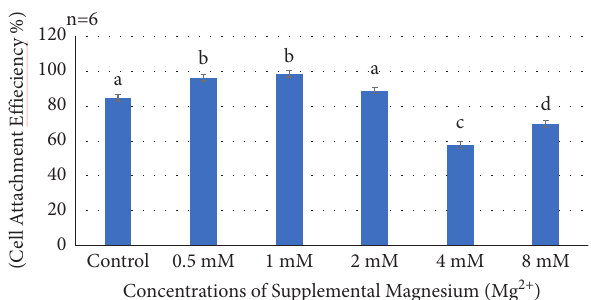
Figure 1: Histogram showing cell attachment efficiency at 16 hours of all supplemental Mg 2+ concentrations. Note: normal human dental pulp cells were cultured for 16 hours with media containing supplemental Mg 2+ concentrations 0.5mM, 1mM, 2 mM, 4mM, and 8 mM and 0mM as the control group. The data are presented as means of six replicates with error bars indicating the standard deviation. Groups labeled with different letters differ statistically as compared to the control group and other study groups ( P < 0 .